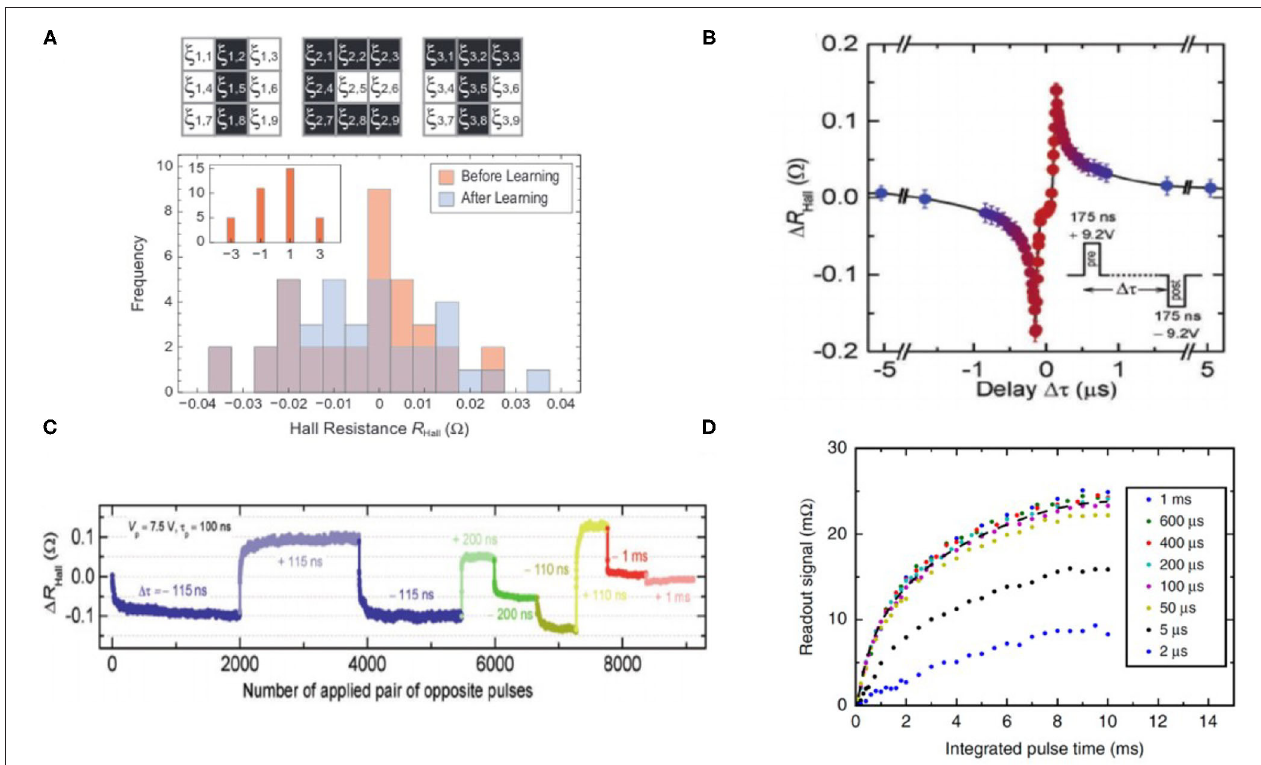
FIGURE 6 | Neuromorphic implementation based on exchange-coupled heterostructures. (A) Modifications of synaptic weights stored in F/AF devices after training for pattern recognition. Figure reproduced with permission from Borders et al. Appl. Phys. Express 10 013007 (2017). (B) STDP demonstration based on the Hall resistance of F/AF devices. (C) Effect of input pulses on the synaptic state of F/AF devices. Figures reproduced with permission from Kurenkov et al. Advanced Materials 31, 1900636 (2019). (D) Resistance modifications of an antiferromagnetic material CuMnAs under pulses of various lengths. Figure reproduced from